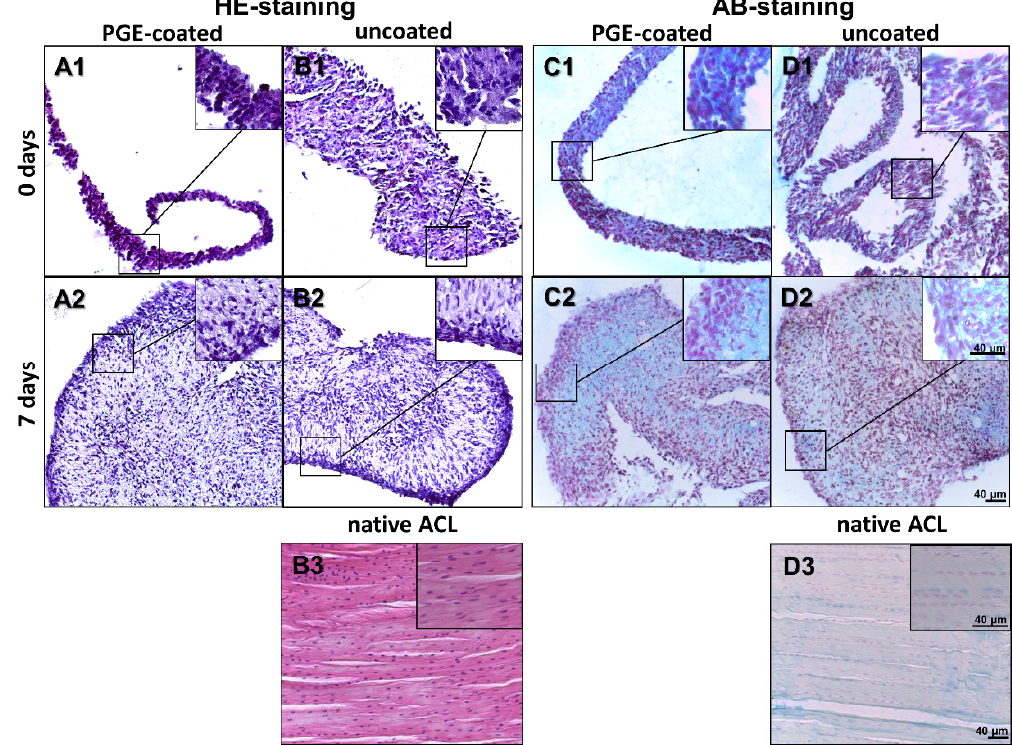
Figure 3. Histology of lapine ligamentocyte sheets (0 d) released from PGE-coated and uncoated plates and after culturing for 7 days. Paraffin sections of sheets released from surfaces coated with poly(glycidyl ether) (PGE) or uncoated plates stained with hematoxylin-eosin (HE, A1, B1,A2,B2 ) or alcian blue (AB, C1,D1,C2,D2 ). 0 d ( A1 , B1 , C1 , D1 ), 7 d ( A2 , B2 , C2 , D2 ). Native lapine anterior cruciate ligament (HE: B3 , AB: D3 ), scale bars: 40 µm.